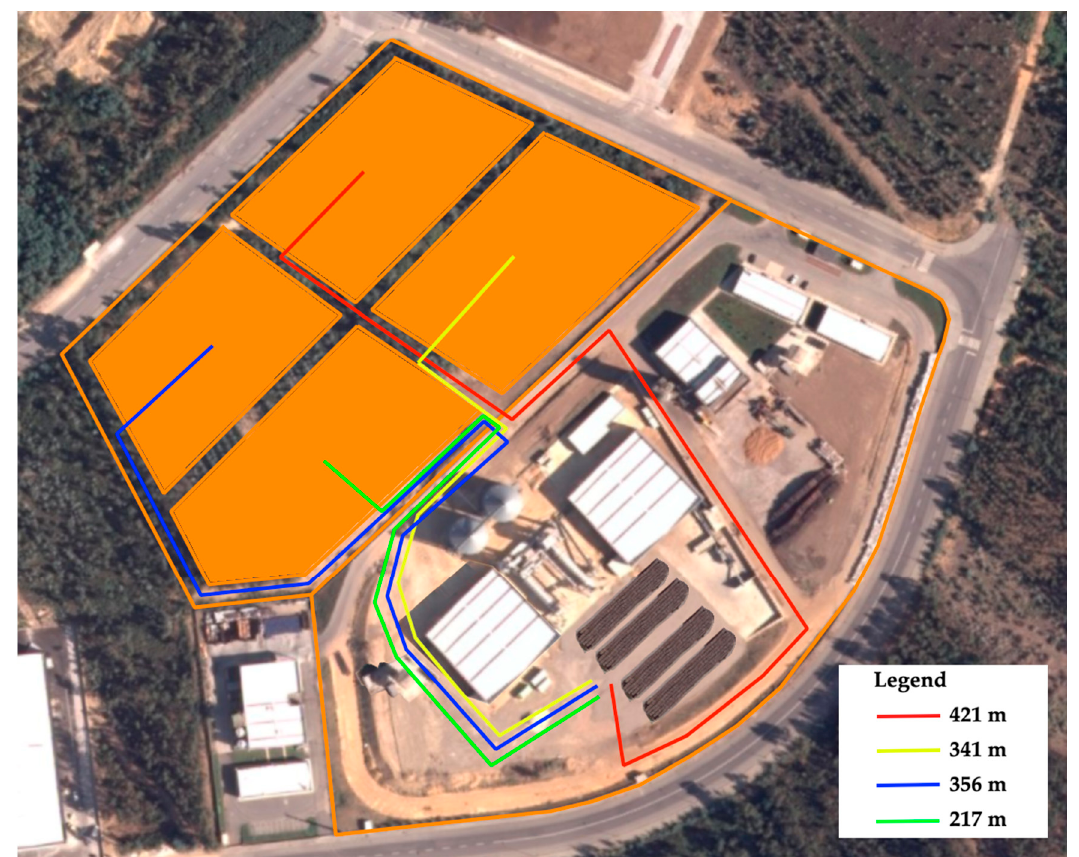
Figure 5. Representation of the average paths between different sectors and P2. Energies 2020 , 13 , x FOR PEER REVIEW